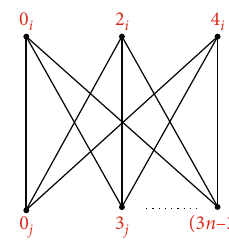
Figure 14: The labelling for ð K